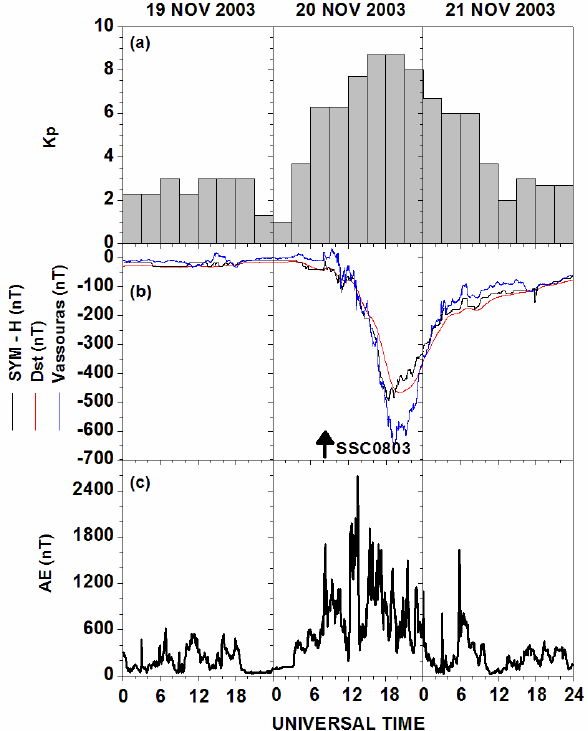
Fig. 2. The variations of the K p , D st , SYM-H and AE geomag- netic indices during the period 19–21 November 2003. Also, the geomagnetic field H-component variations during the period 19–21 November 2003, observed at Vassouras, Brazil, are